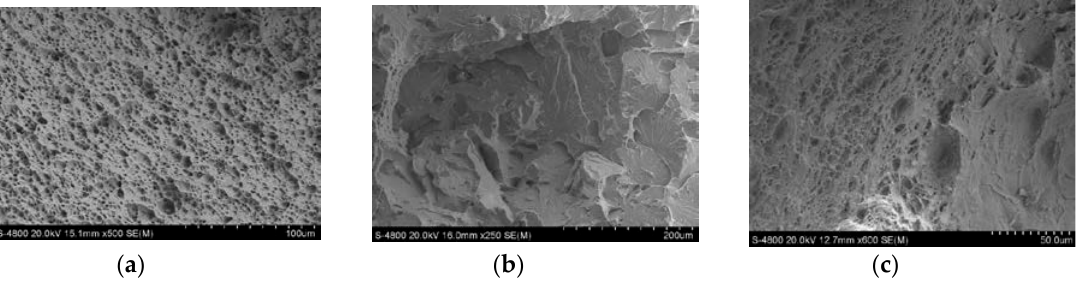
Figure 3. Sample of micro-fracture ( − 20 °C): ( a ), impact fracture of 16 mm thickness plate; ( b ), impact fracture of 25 mm thickness plate; ( c ), impact fracture of 40 mm thickness plate.